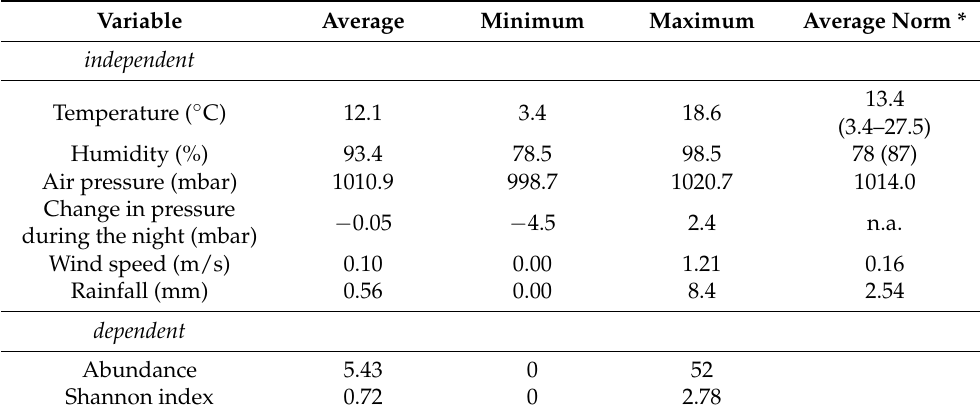
Table 3. Descriptive statistics. Averages and extreme values of trap-specific nightly mean